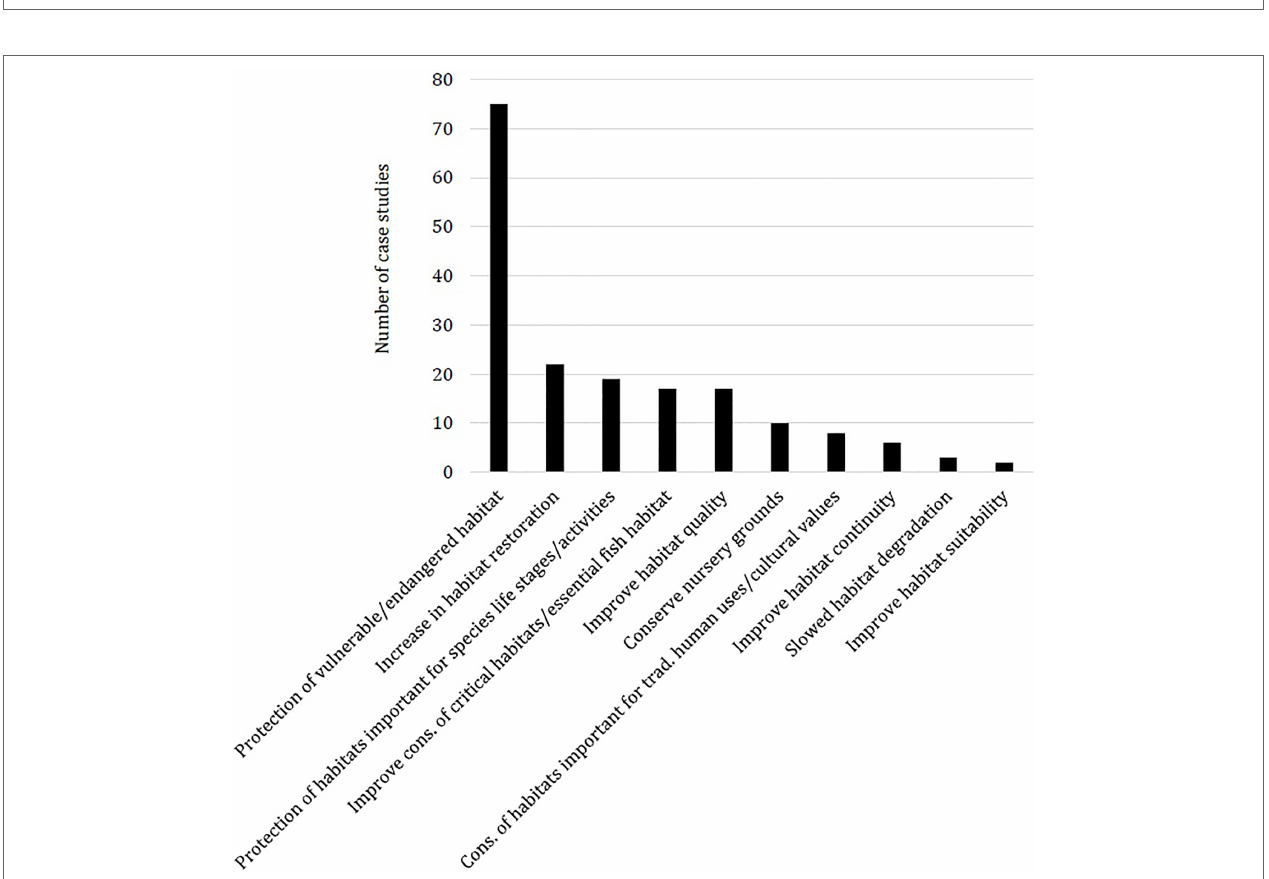
FIGURE 4 | Frequency of case studies for which habitat level biodiversity conservation outcomes were